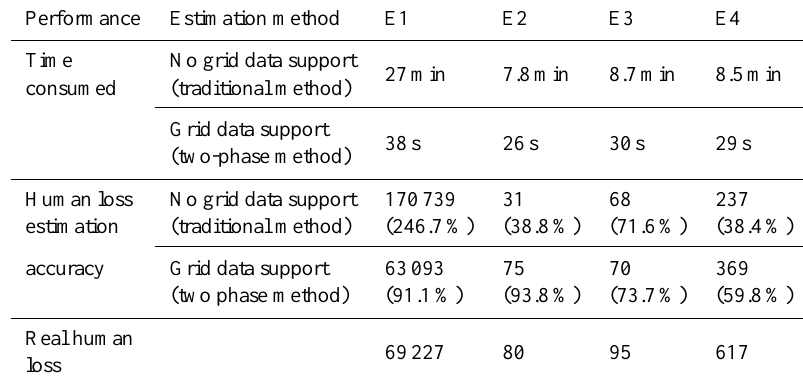
Table 5. Comparison of calculation speed and accuracy for the test